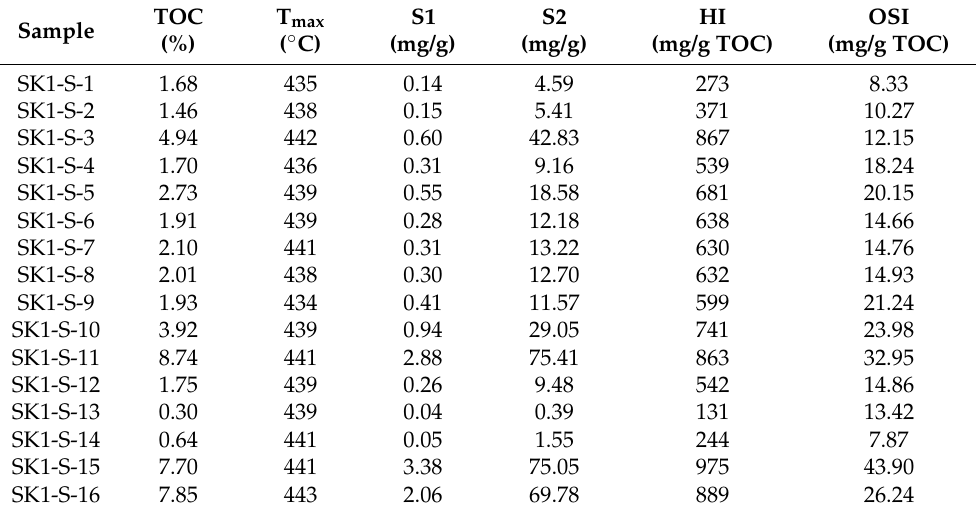
Figure 7. Relationship between TOC content and hydrocarbon generation potential of K 2 n 1+2 shale. ( a ) S2 versus TOC plot showing the quantity and quality of the organic matter, kerogen type, trend HI (HIL), and dead carbon content. ( b ) Relationship between TOC content and S1. Table 6. Rock-Eval data of K 2 n 1+2 shale, Songliao